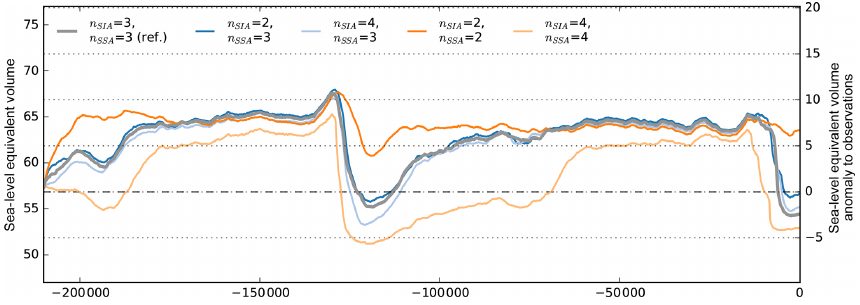
Figure 4. Simulations with different flow-law exponents in the SIA and SSA stress balance, varying from 2 to 4. For variation in the SIA flow-law exponent we find only small impact on ice volume (blue, grey and light blue), while for the SSA it strongly affects ice sheet growth and deglaciation (orange and light